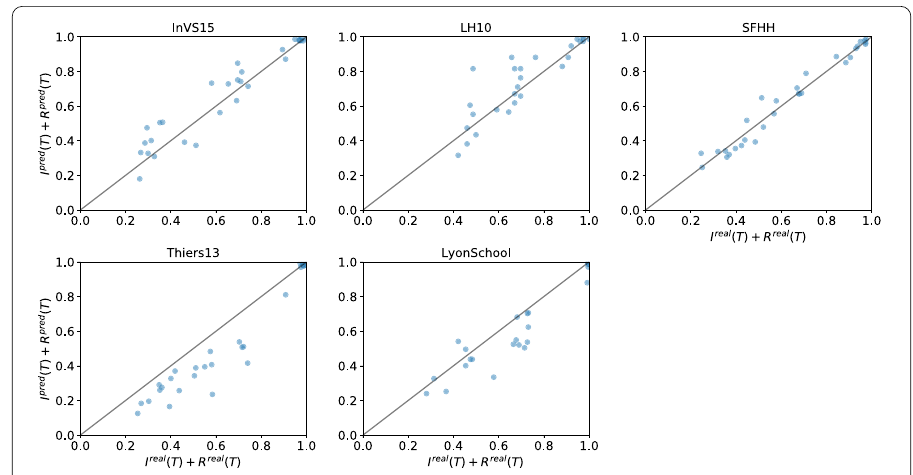
Figure 4 Scatterplots of the final predicted epidemic size (number of infectious and recovered nodes at the end of the data set), vs. the real one. Each point corresponds to one simulation, and we vary the epidemic parameters in order to scan a wide range of outcomes. Here we use the dyn-supra + DeepWalk method. The Pearson correlation coefficients for the predicted vs. real sizes are 0.957 for InVS15, 0.88 for LH10, 0.98 for SFHH, 0.96 for Thiers13 and 0.95 for